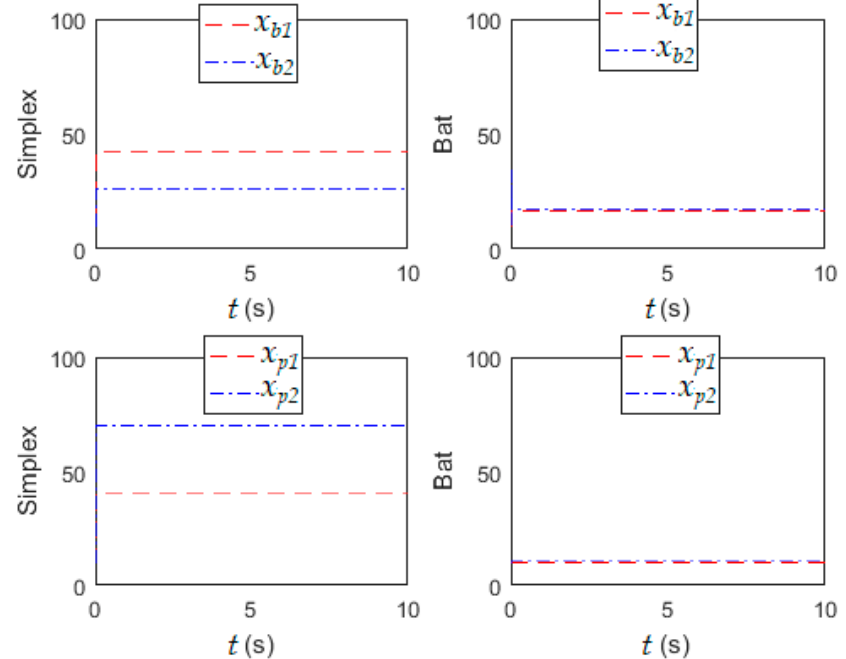
Figure 4. Evolution of the gain values.